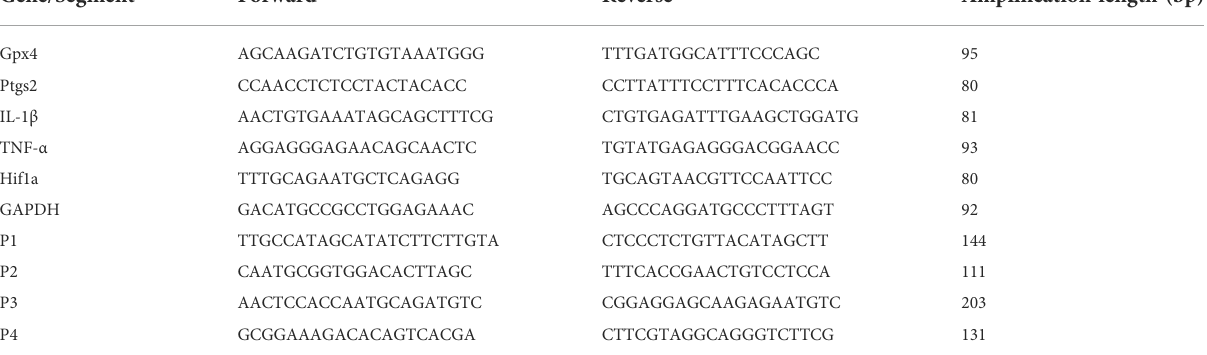
TABLE 2 Primer used in the